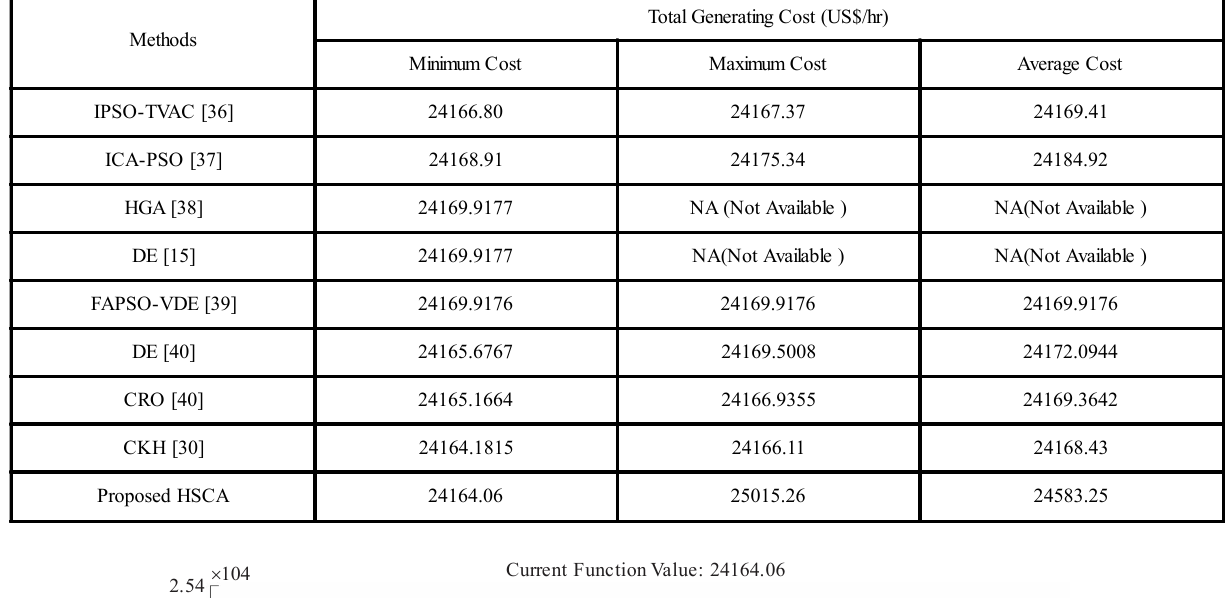
TABLE 3. STATISTICAL COMPARISON OF 13 UNIT TEST